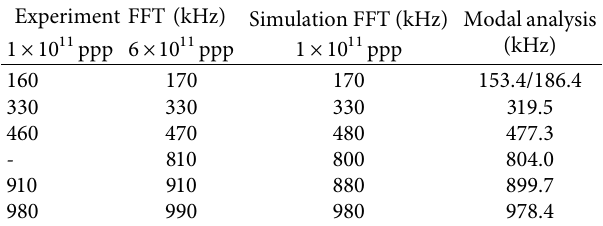
Figure 8: Recorded surface velocity (solid blue line) and calculated damping envelope (red dashed line) as a function of time up to 200 μ s after beam impact. (a–c) compares three different polycrystalline graphite samples: #1 SGL R6650 (a), #6 SGL R6650 (b), and #3 POCO ZEE (c) at 1 × 10 11 ppp (top) and 6 × 10 11 ppp (bottom) beam intensity. The energy density provided in each plot indicates the peak energy deposition in the tantalum core averaged over the length of the sample. Table 3: Comparison of frequency components identified in the FFT of the experimental results, the FFT of the simulations for a beam intensity of 1 × 10 11 ppp, and modal analysis of the target geometry. Frequencies obtained from FFT have a systematic error of ±